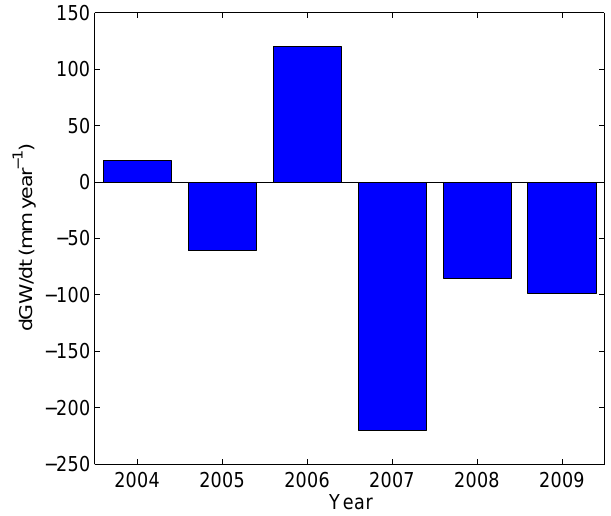
Figure 4. Annual groundwater change for the Central Valley de- rived from GRACE.